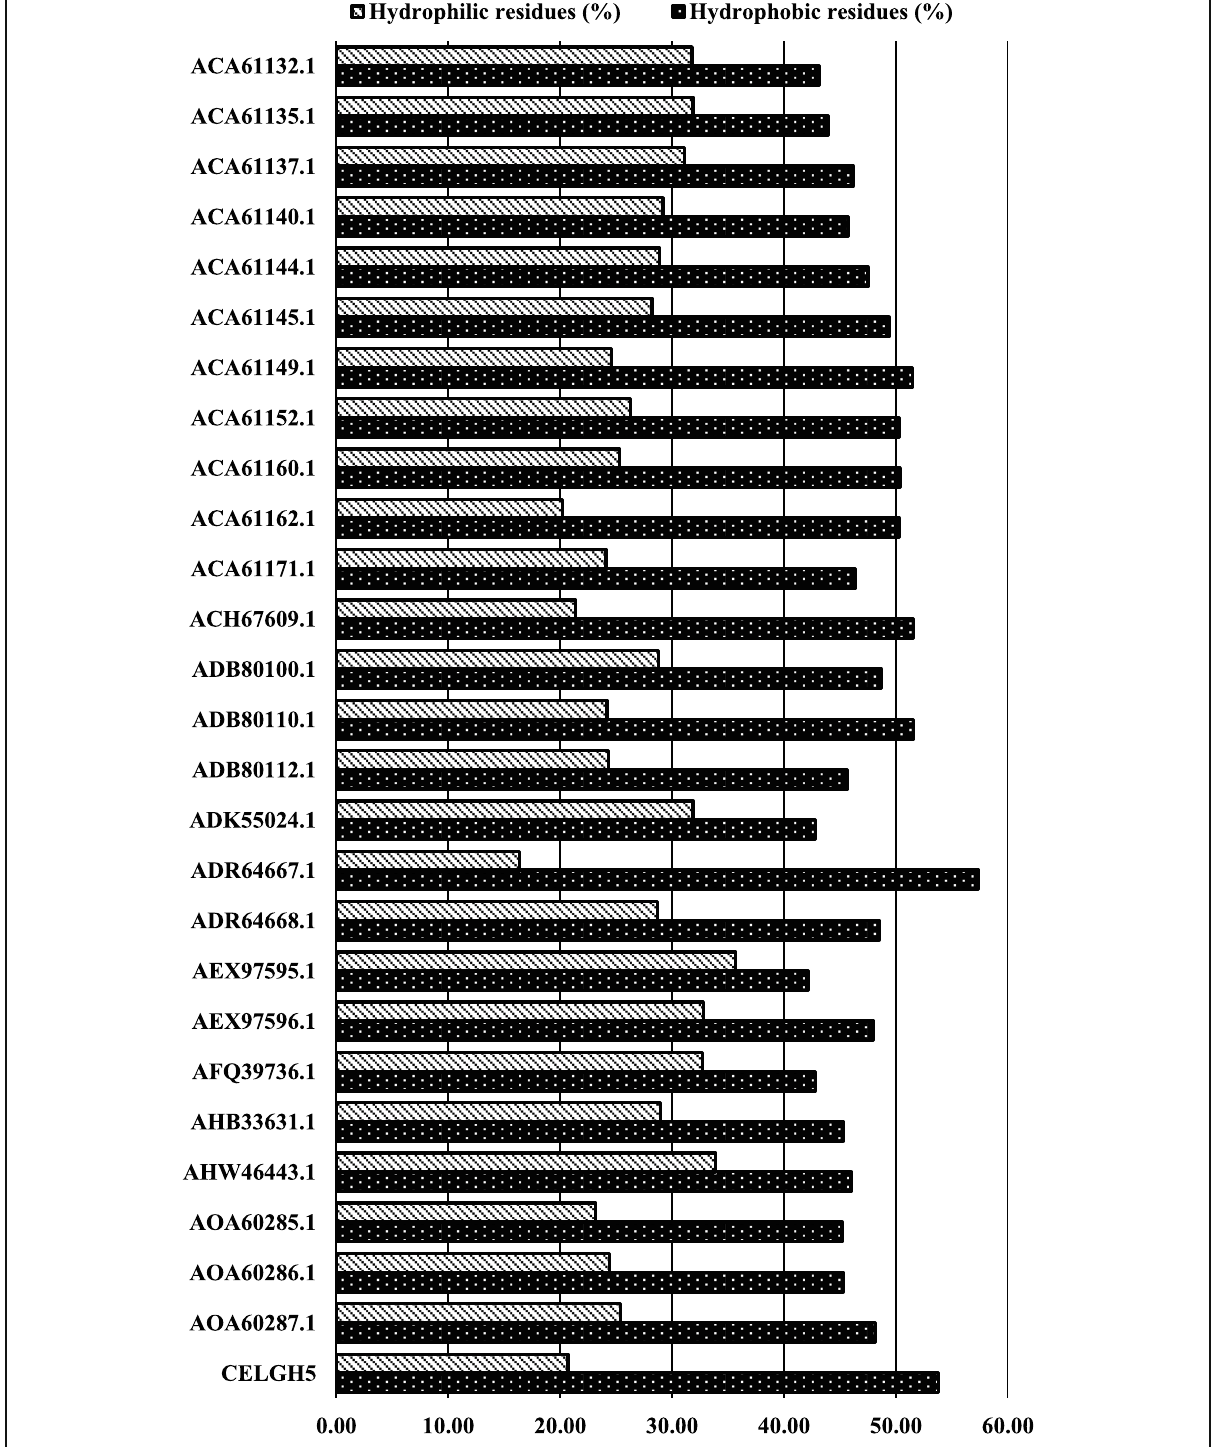
Fig. 4 Frequencies of hydrophobic and hydrophilic residues. Hydrophobic residues: A, F, G, I, L, M, P, V, W; hydrophilic residues: C, N, Q, S, T,